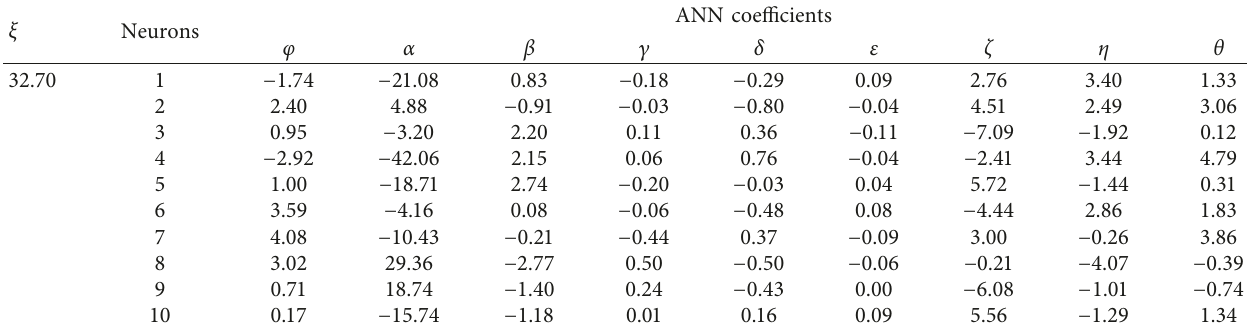
Table 9: ANN coefficients for the Marshall flow prediction model.